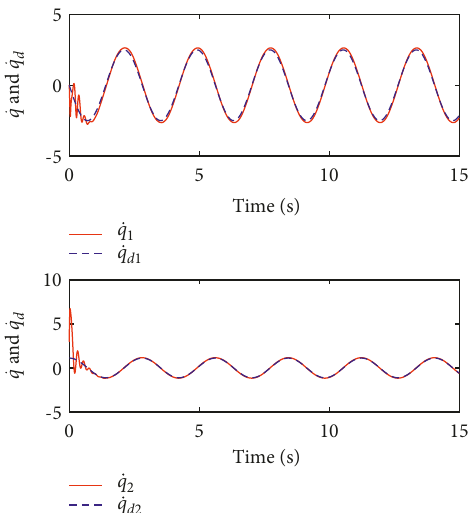
Figure 20: Profiles of CNN weights with (21). d .